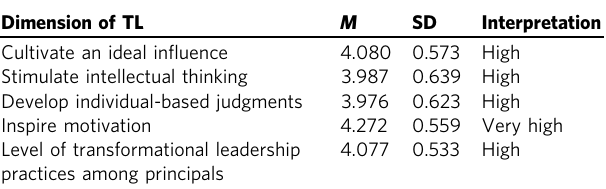
Table 6 The means and standard deviations for TL items.